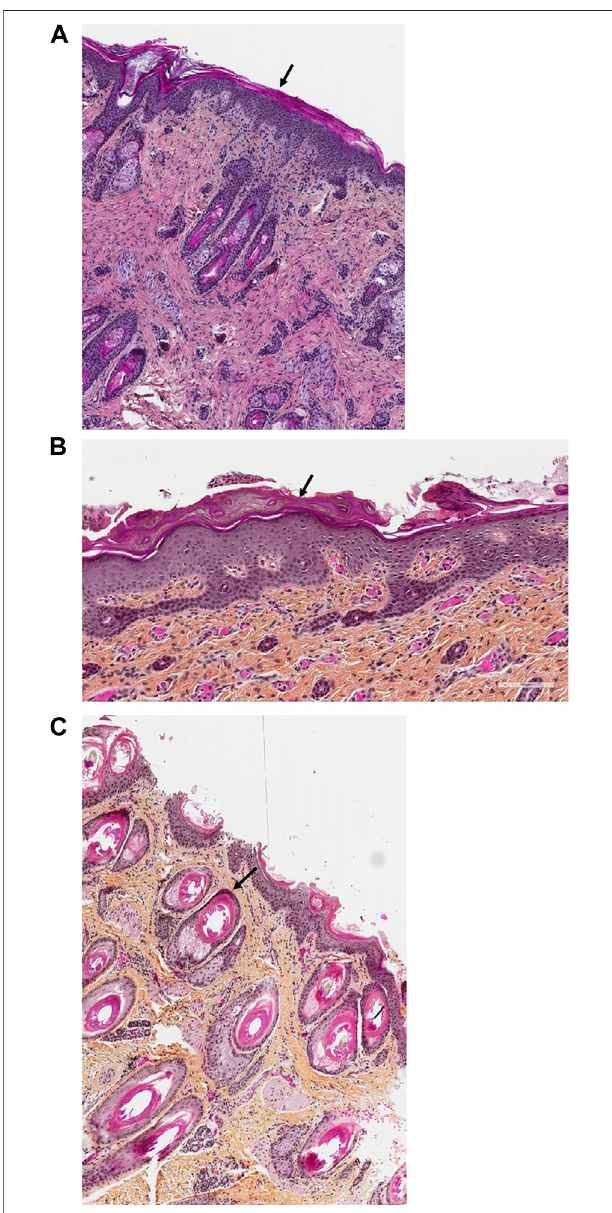
FIGURE 5 | (A – C) . Skin histology of Patients 1 and 2. In the histopathological examination of the skin (H&E staining) from the abdominal wall along the incision that was performed for internal examination in the fi rst child ( Figure 5A ,magni fi cation × 40)andfromtherightinner thigh ofthesecond affected child ( Figure 5B , magni fi cation × 100), the epidermis exhibited global compactorthohyperkeratosiswithmoderatetoseverehyperplasiaofthestratum corneum (arrows). The granular layer encompassed one cellular layer; there was acanthosis and no epidermal or sub-epidermal detachment (no bullae) and no in fl ammatory in fi ltrate with leucocytes or erythrocyte. Pronounced follicular pluggingwithonionscale-likekeratindepositswereseeninthehairfollicleori fi ces from the second child ( Figure 5C , magni fi cation × 100,